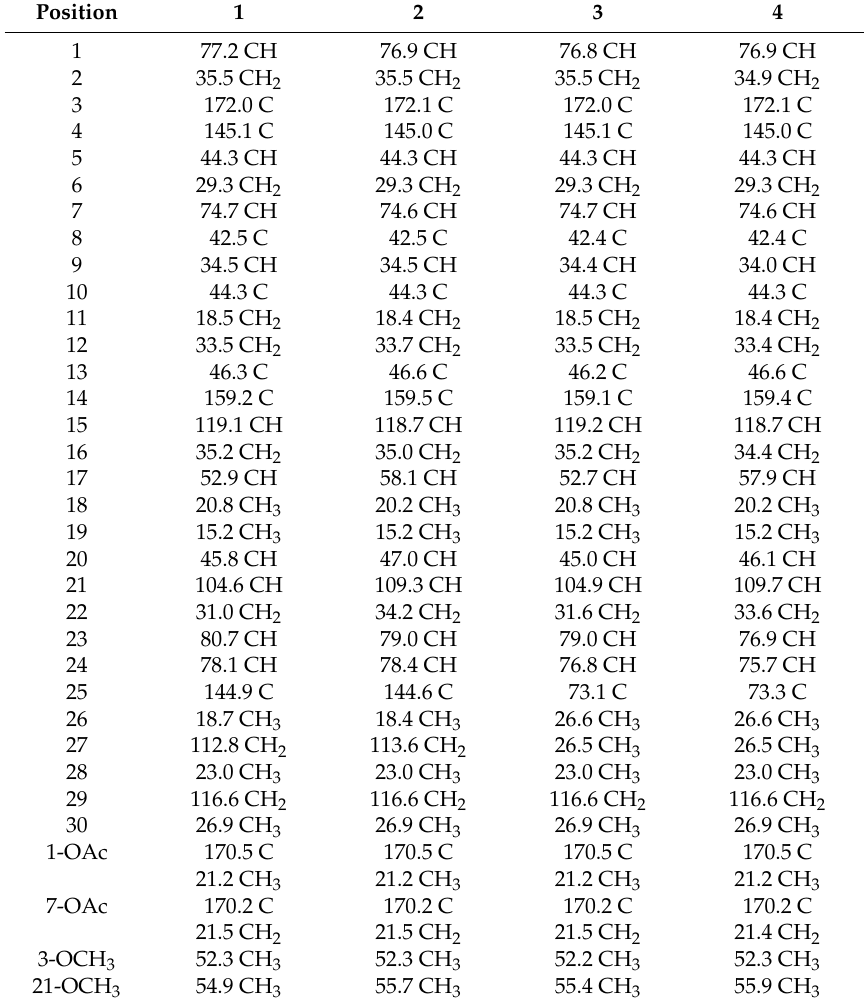
Table 2. 13 C-NMR spectroscopic data (100 MHz) of compounds 1 – 4 a